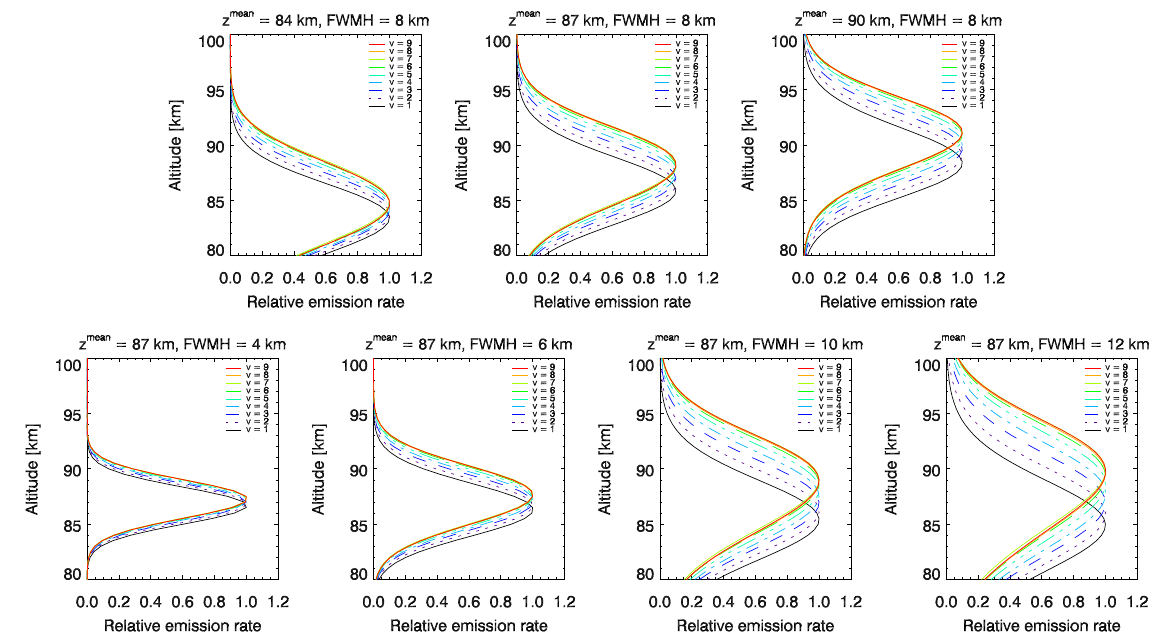
Fig. 10. Sensitivity of the modelled vertical emission rate profiles to peak altitude (top row) and peak width (bottom) of the initially produced OH ∗ profile. The initially produced profile is assumed to follow a Gaussian function with peak altitude z mean and a given FWHM. The rate constants for quenching by atomic oxygen and molecular oxygen are the corrected values published in Xu et al. (2012).